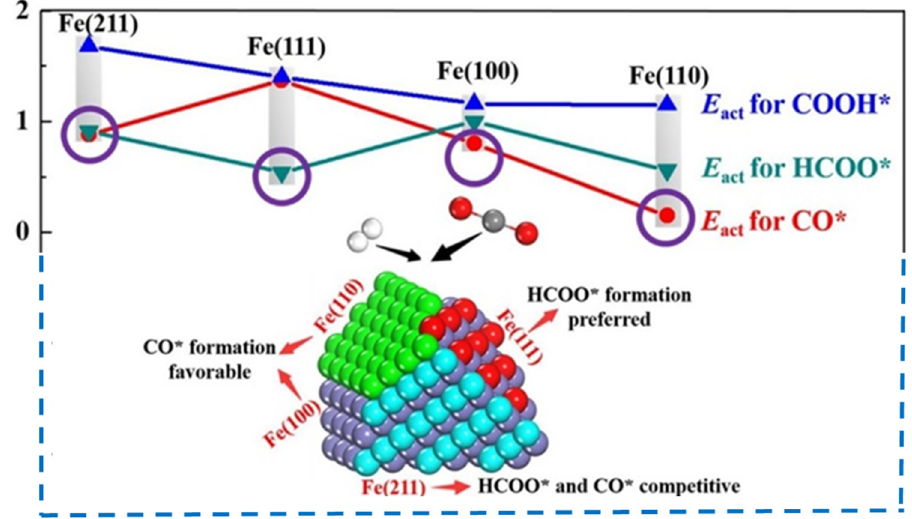
Figure 5. Energetically favorable adsorption configuration of CO 2 and H 2 on the Fe(100), (110), (111) and (211). Reproduced from Ref. [36] with copyright licence from Elsevier.